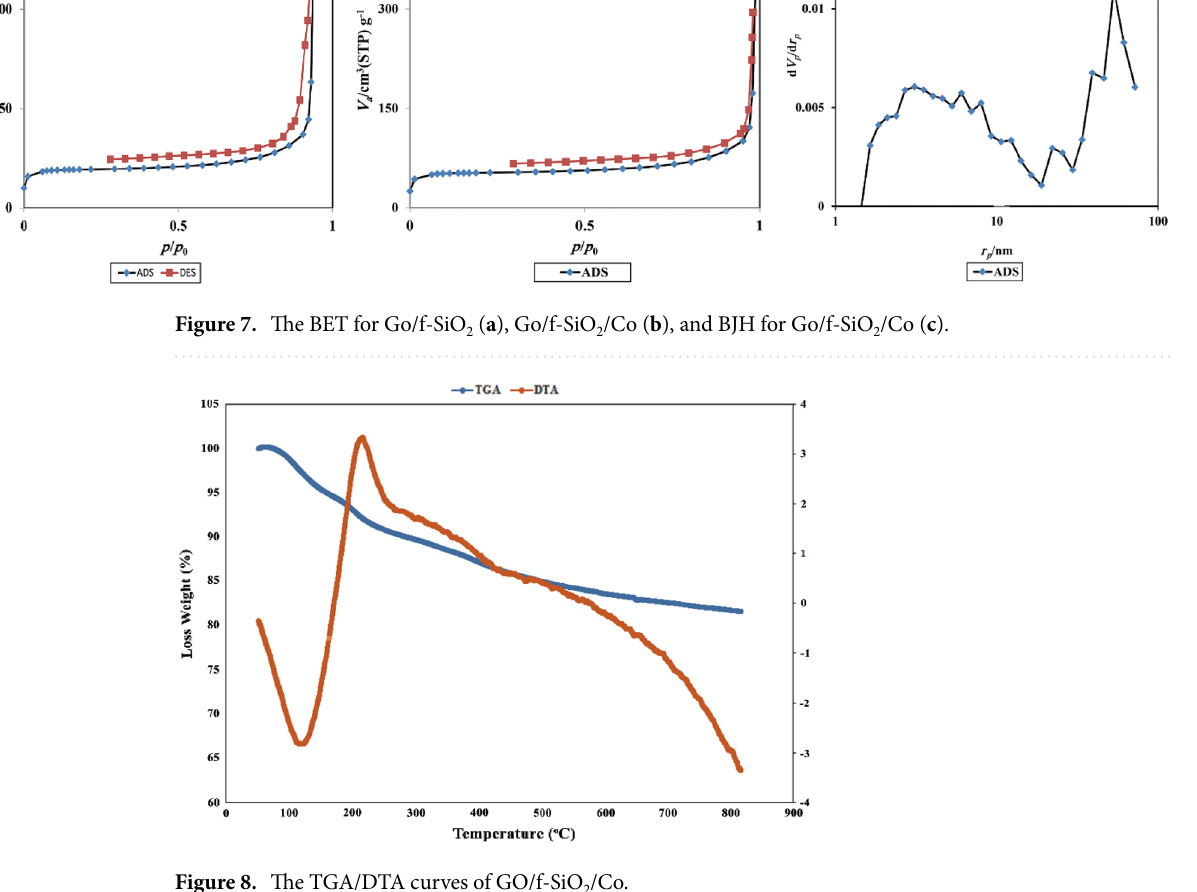
Figure 8. The TGA/DTA curves of GO/f-SiO 2